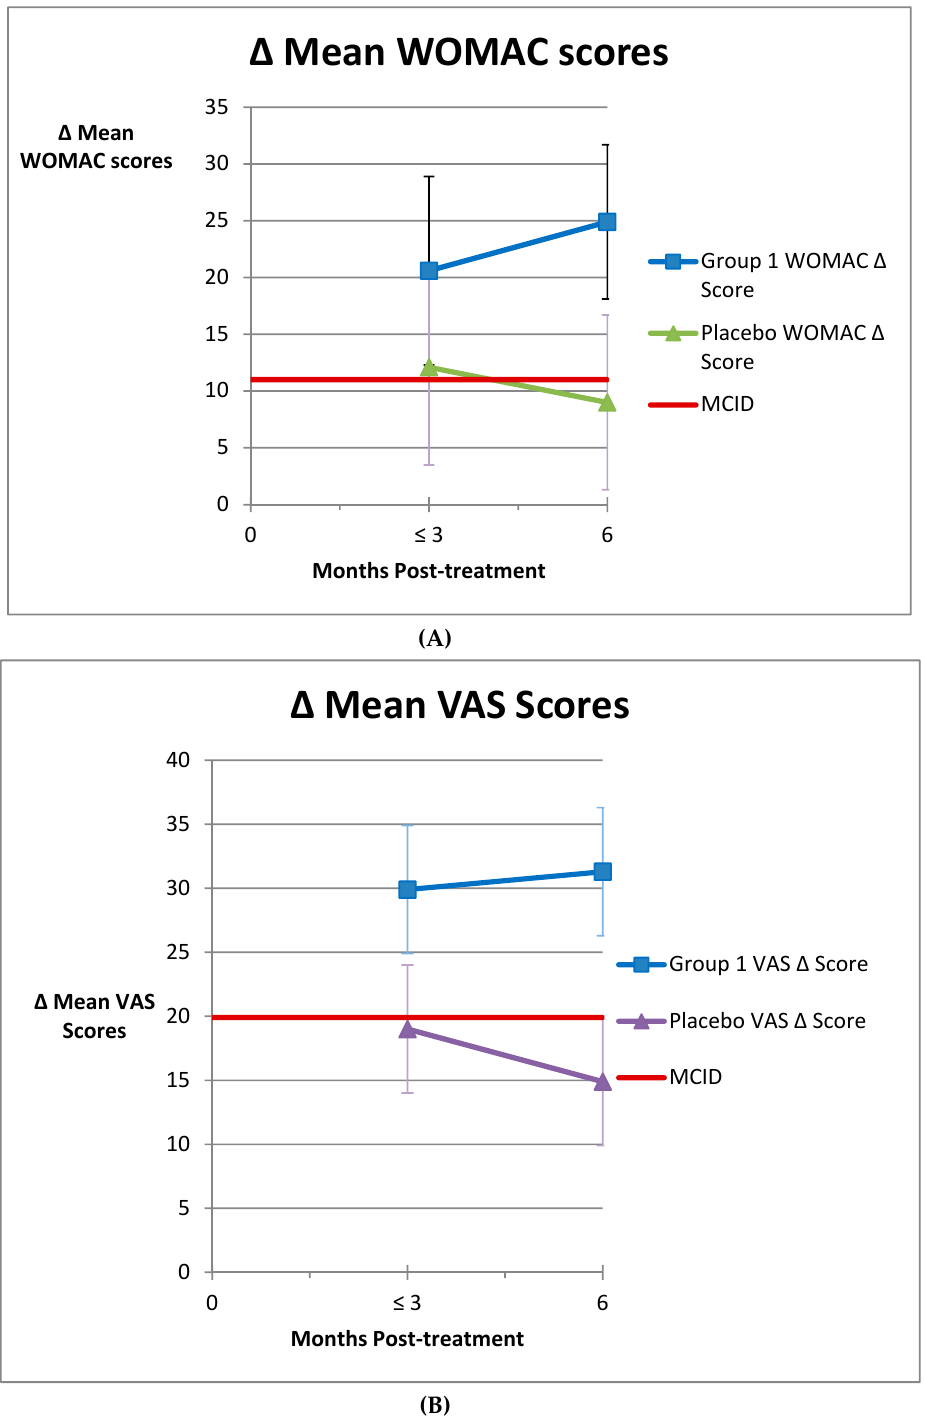
Figure 3. ( A ) Comparison of maximum mean WOMAC improvement before 3 months post-treatment compared to 6 months post-treatment for Group 1 and placebo patients. Vertical bars indicate 95% confidence interval. Comparison of means between Group 1 and placebo was p = 0.02 at ≤ 3 months and p =< 0.0001 at 6 months. ( B ) Comparison of maximum mean VAS improvement before 3 months post-treatment compared to 6 months post-treatment for Group 1 and placebo patients. Vertical bars indicate 95% confidence interval. Comparison of means between Group 1 and placebo was p = 0.02 at ≤ 3 months and p = 0.001 at 6 months.